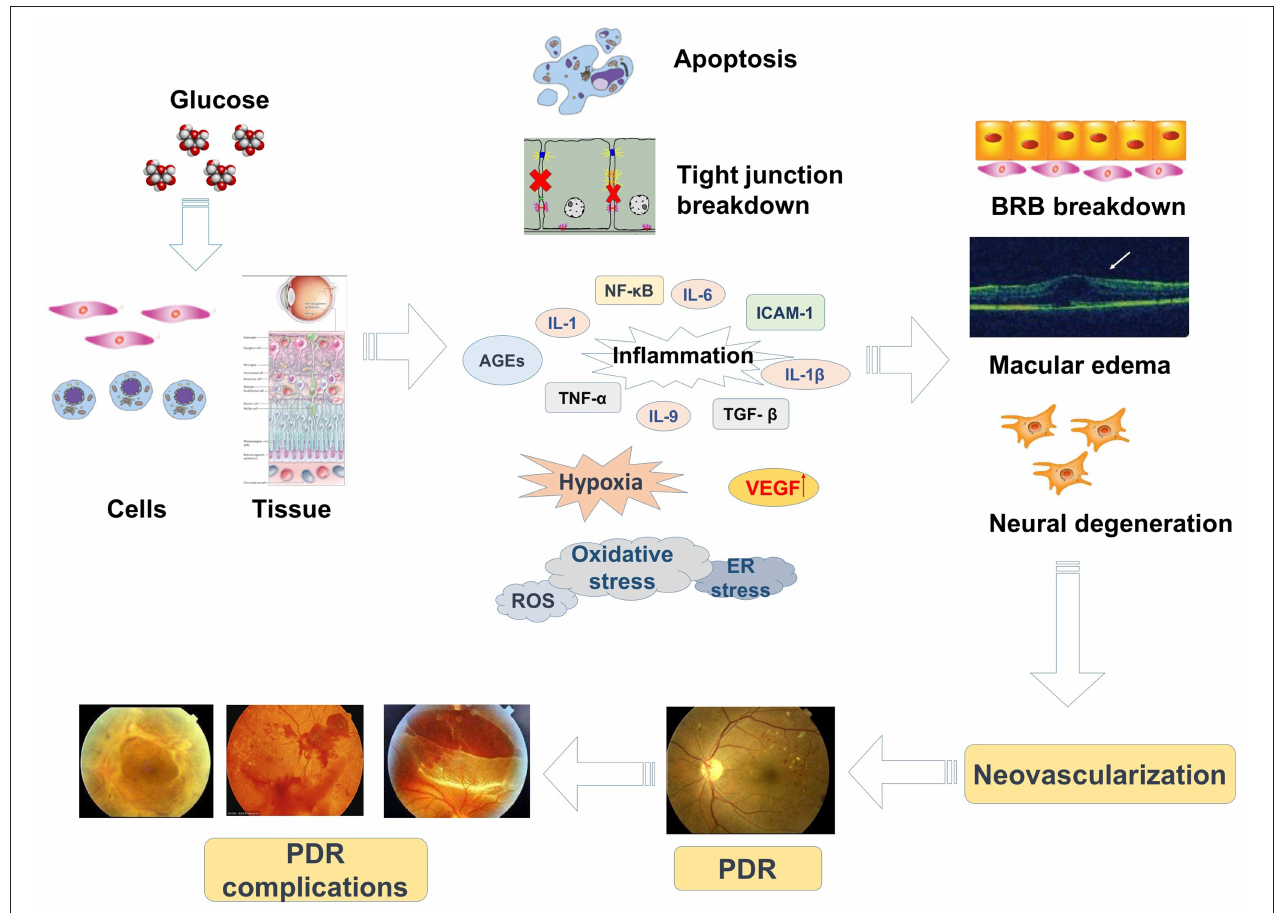
FIGURE 1 | The pathogenic mechanisms and progression of